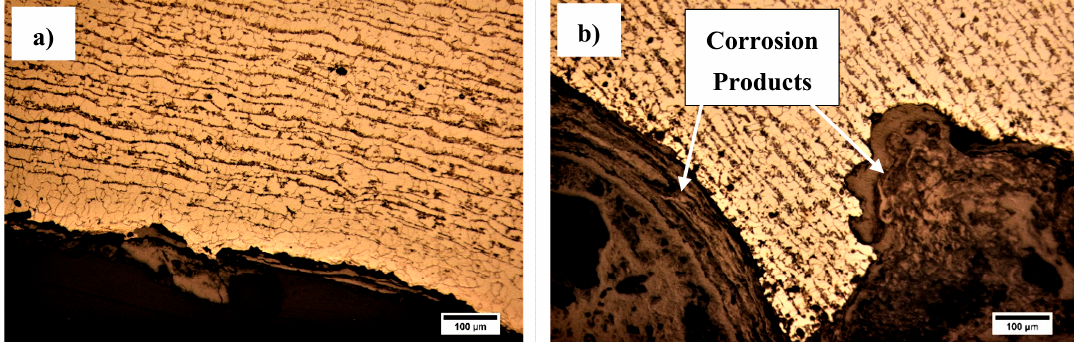
Figure 4. The optical microscopy (OM) microstructures of the ( a ) inner surface and ( b ) the outer surface.